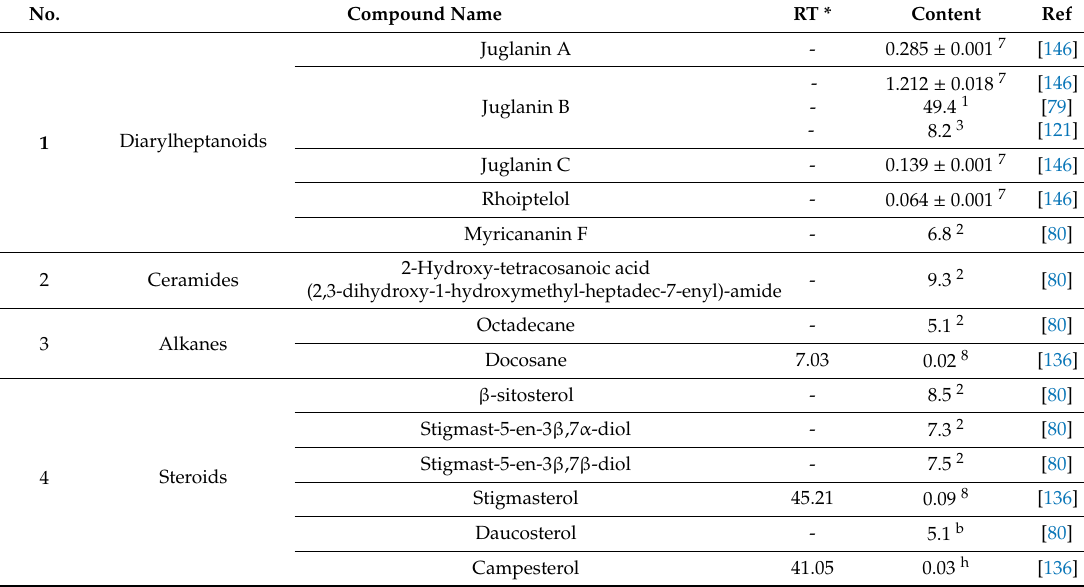
Figure 11. The chemical structures of di ff erent identified, isolated, and quantified diarylheptanoids, ceramides, and alkanes in the green husk of walnut. Di ff erent identified diarylheptanoids, ceramides, alkanes, steroids, triterpenoids, sesquiterpenes, and neolignans in green walnut husk along with the retention time and content.